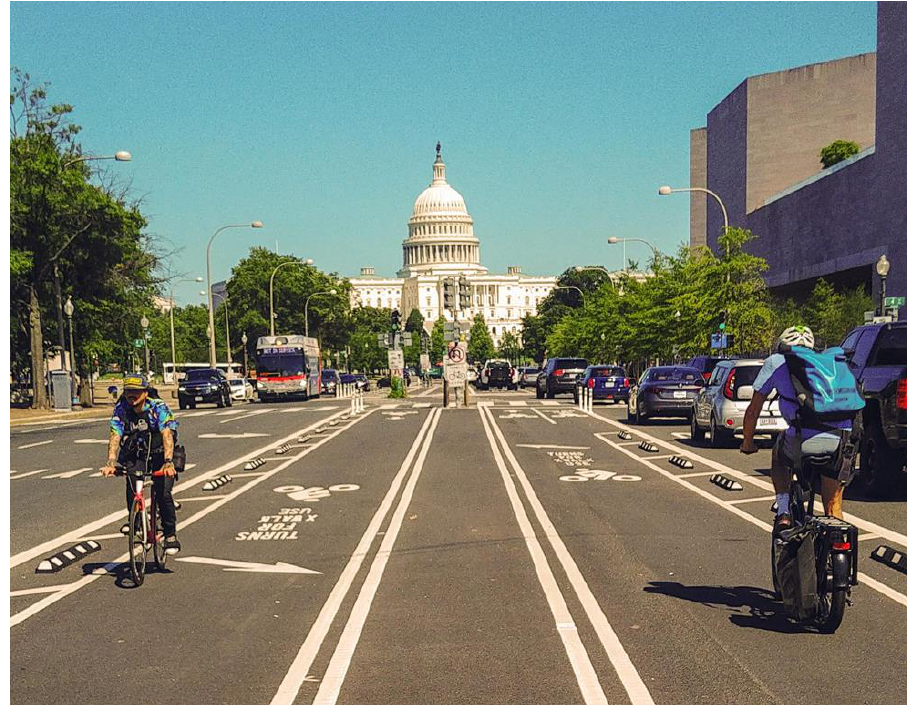
Figure 3. Cyclists on bike lanes on Pennsylvania Avenue in Washington, DC, connecting the U.S. Capitol to the White House (Photo: Ralph Buehler).